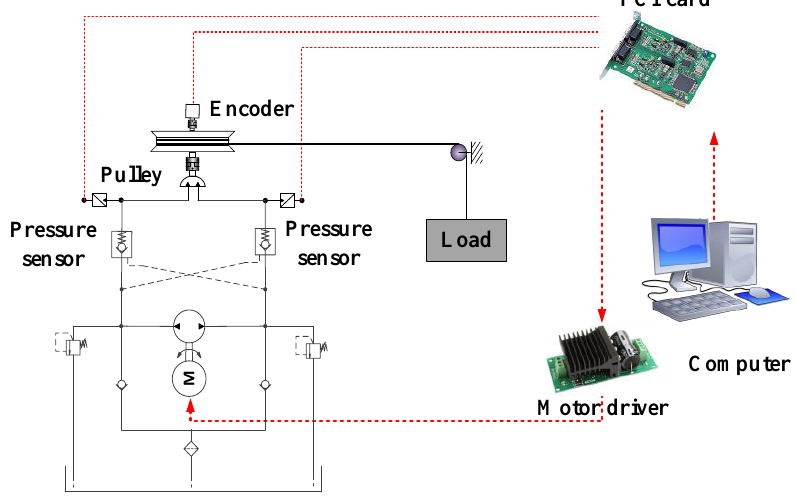
Figure 11. Structure of the experimental loading system using EHRA.